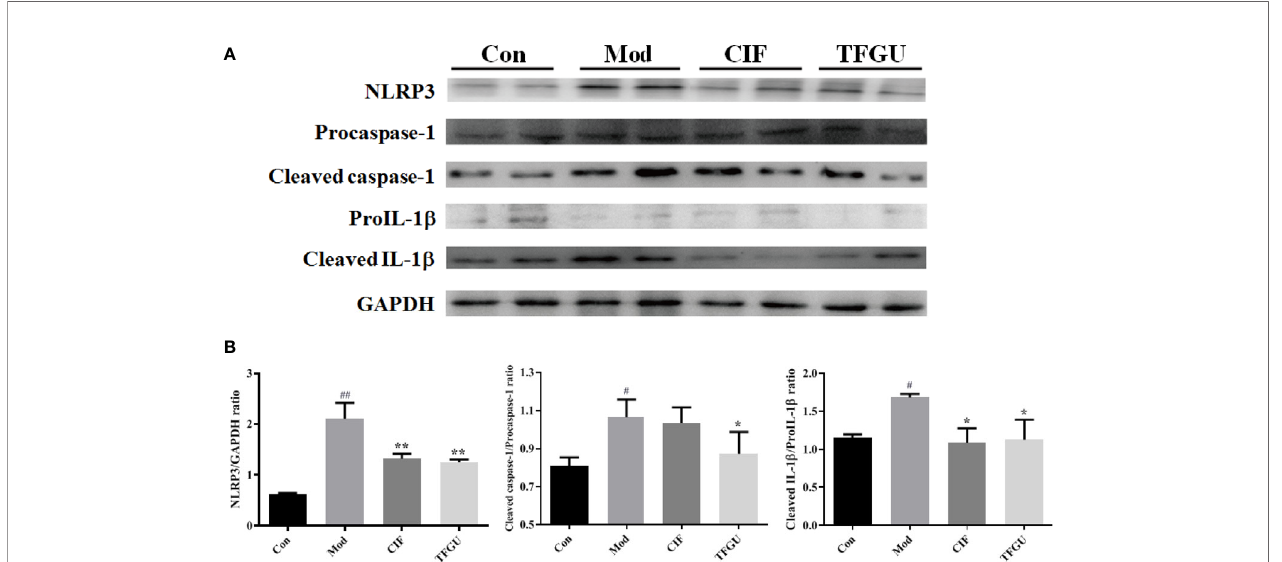
FIGURE 9 | Effects of TFGU on the colonic expression of the NLRP3 in fl ammasome complex activated by CPT-11. (A) The representative images of Western blotting analysis of NLRP3, Procaspase-1, Cleaved caspase-1, ProIL-1 b , and Cleaved IL-1 b . (B) The quanti fi cation of Western blotting analysis of NLRP3, Cleaved caspase-1/Procaspase-1, and Cleaved IL-1 b /ProIL-1 b . Date are shown as mean ± SD (n = 3). # P < 0.05, ## P < 0.01 vs. Con group, while * P < 0.05, ** P < 0.01 vs. Mod